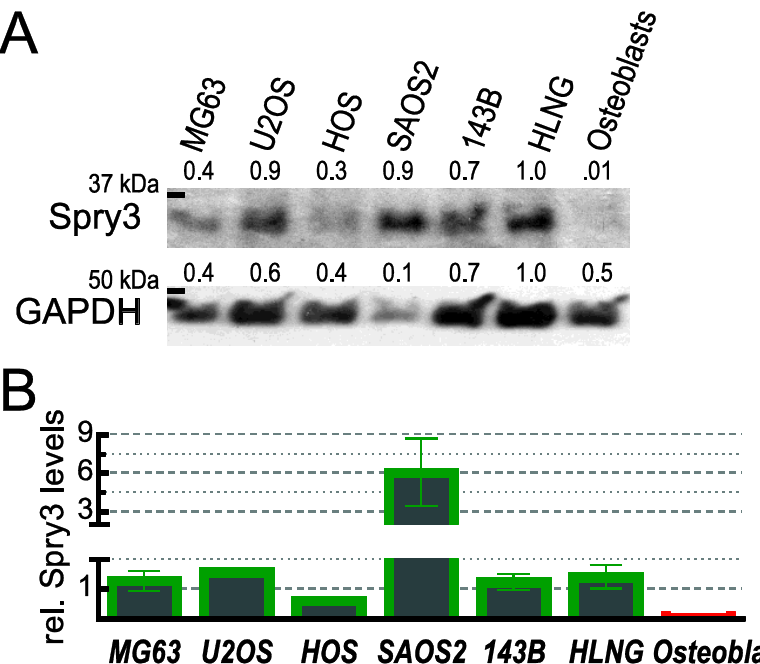
Figure 8. Expression of Spry3 protein in osteoblasts compared to osteosarcoma-derived cell lines. ( A ). Logarithmically growing cell lines derived from osteosarcoma- derived cell lines and from primary human osteoblasts were analyzed by an immunoblot sequentially probed with Spry3 and GAPDH. ( B ) Amounts of Spry3 proteins were measured by Image Quant software and normalized to GAPDH. The highest value was arbitrarily set as 1. Quantification results of two Western blots were depicted as mean ± SEM are shown in a column graph.